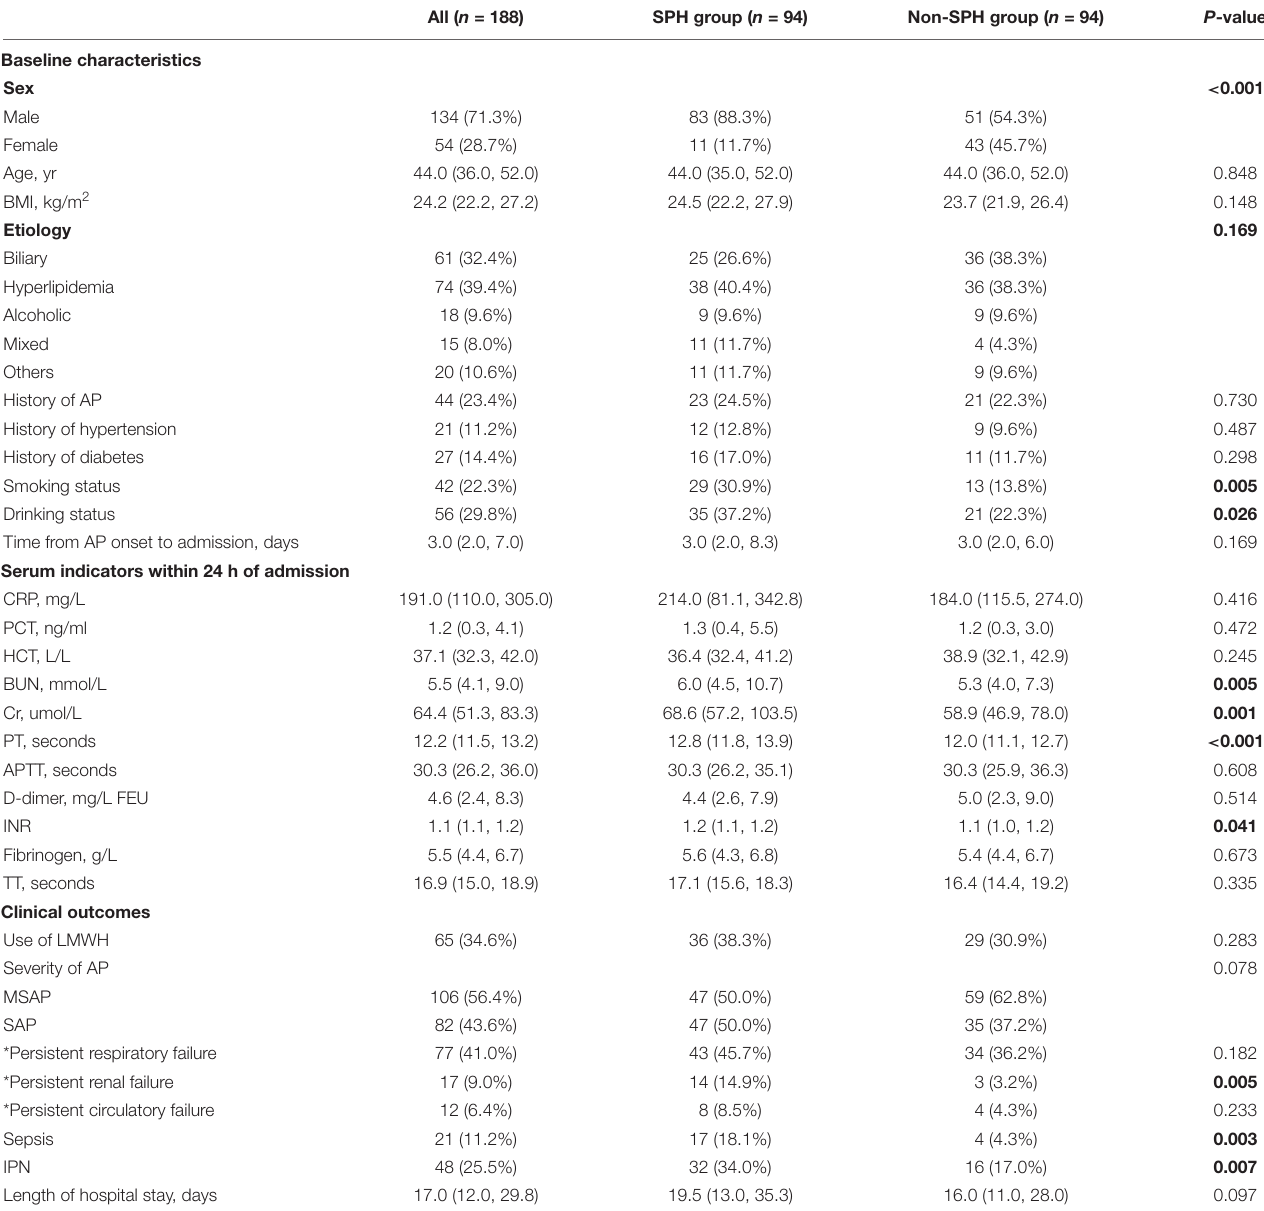
TABLE 1 | Baseline characteristics, serum laboratory indicators, and clinical outcomes of all patients. All ( n = 188) SPH group ( n = 94) Non-SPH group ( n = 94) P